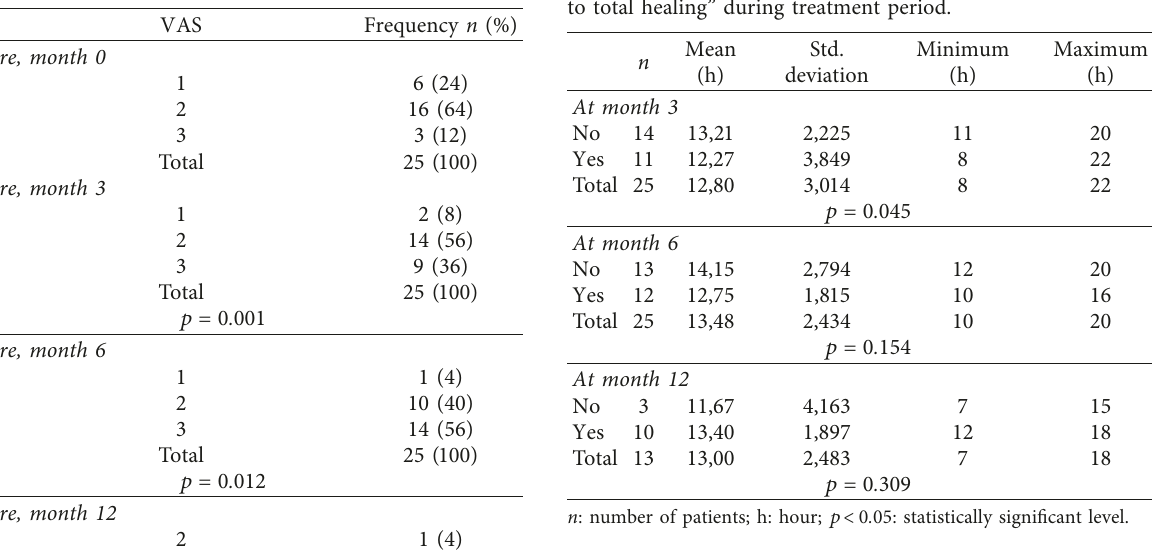
Table 1: Statistic calculation of the patient’s variables including “diet score” during treatment period.